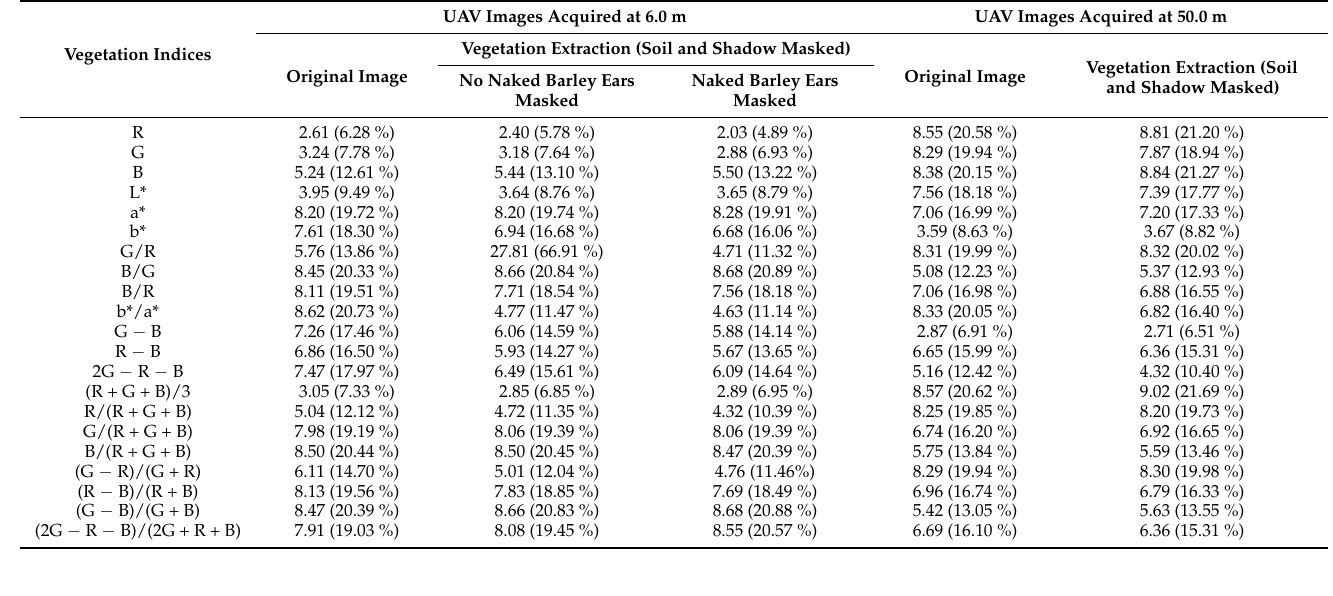
Table 5. RMSE (NRMSE) of the validation for SPAD values estimation with vegetation indices derived from UAV images.